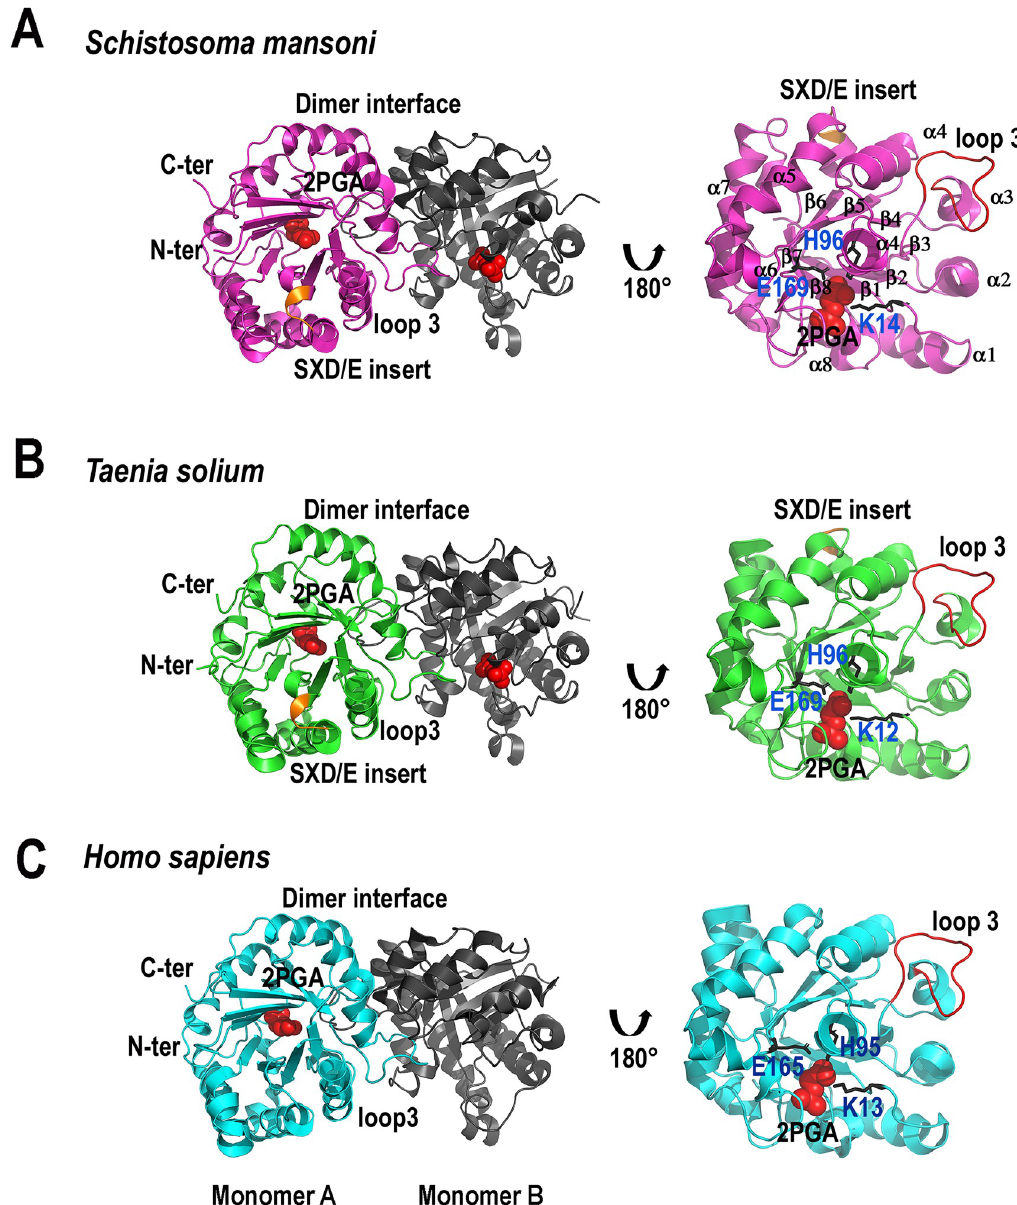
Fig 2. Crystal structures of TsTPI and SmTPI in comparison to HsTPI. A) Ribbon representation of SmTPI. Monomer A is colored in magenta and monomer B is colored in black. Residues corresponding to the SXD/E motif are colored in orange. The 2-PGA inhibitor is colored in red and represented as spheres. B) Ribbon representation of SmTPI. Monomer A is colored in green and monomer B in black. The SXD/E motif is also colored in orange. C) Ribbon representation of HsTPI. Monomer A is colored in blue. In this crystal structure the inhibitor 2-PGA is bound in only one subunit [59]. The right part of the figure shows a magnification of monomer A for SmTPI, TsTPI, and HsTPI. Loop 3, involved in the assembly the dimer interface, is colored in red. The conserved structural secondary elements are labeled only for